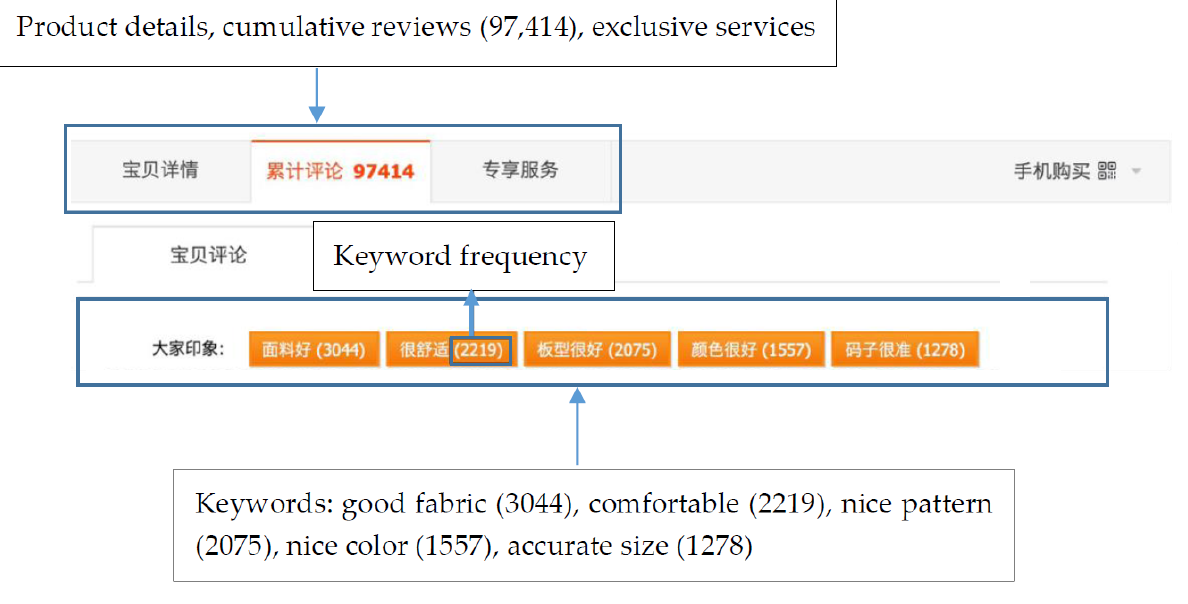
Figure 1. Review keywords on Taobao (source: https://www.taobao.com/) (accessed on 9 Novem ‐ ber 2020).